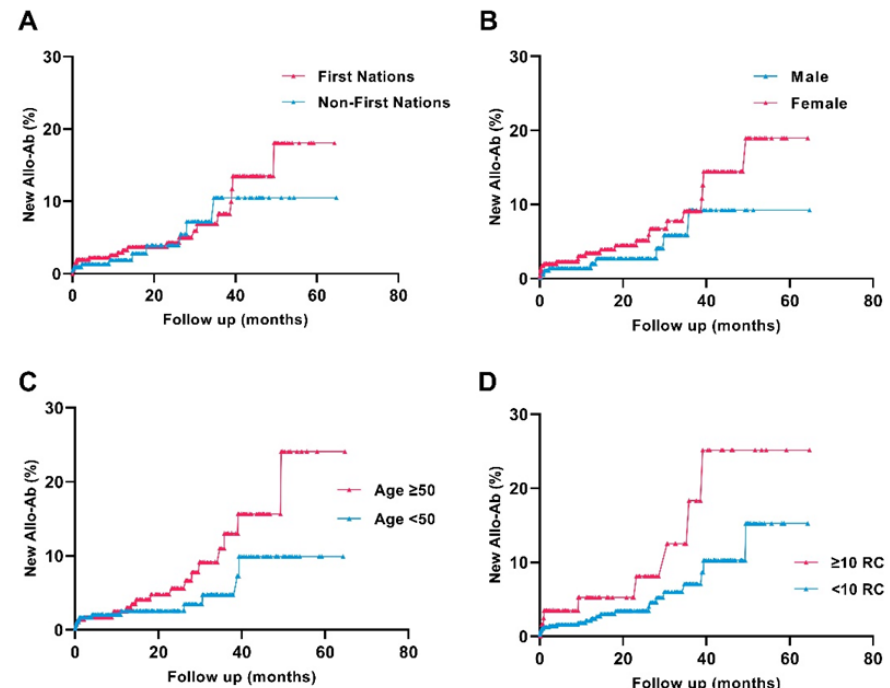
Figure 4. Kaplan–Meier curves for new incident clinically significant red cell alloantibodies (Allo-Ab) grouped by First Nations status ( A ), sex ( B ), age categorised as <50 or ≥ 50 ( C ), and cumulative red cell transfusion exposure from date of index ICU admission (categorised as <10 and ≥ 10 units packed red blood cells) ( D ).